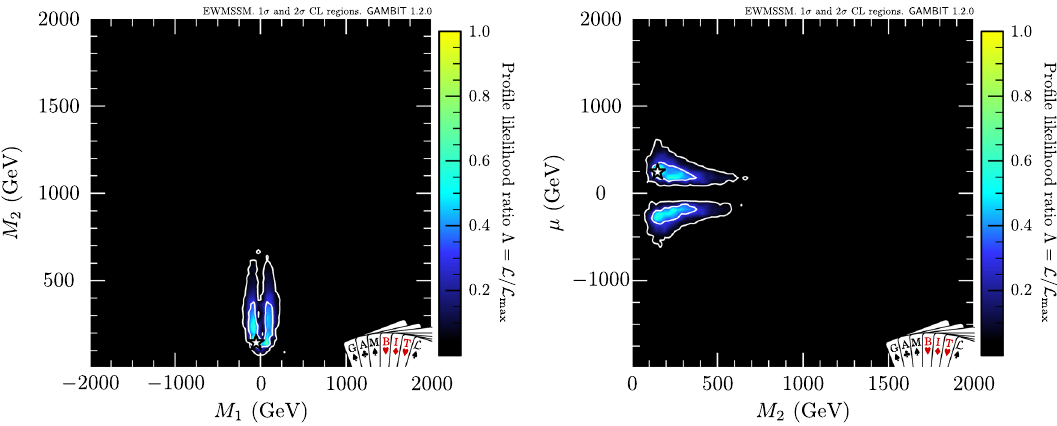
Fig. 16 Profile likelihood in the ( M 1 , M 2 ) plane (left) and the (μ, M 2 ) plane (right). The contour lines show the 1 σ and 2 σ confidence regions. The best-fit point is marked by the white